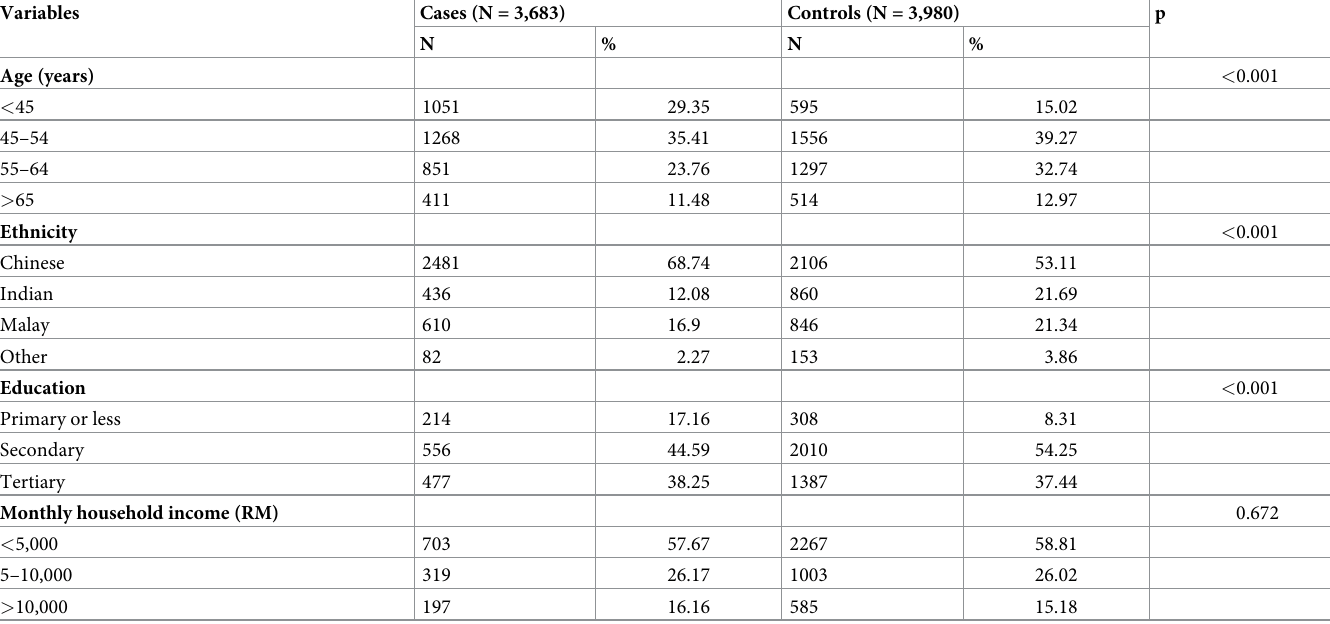
Table 1. Socio-demographic characteristics of 3,683 breast cancer cases and 3,980 controls in a hospital-based case-control study of breast cancer. Variables Cases (N =